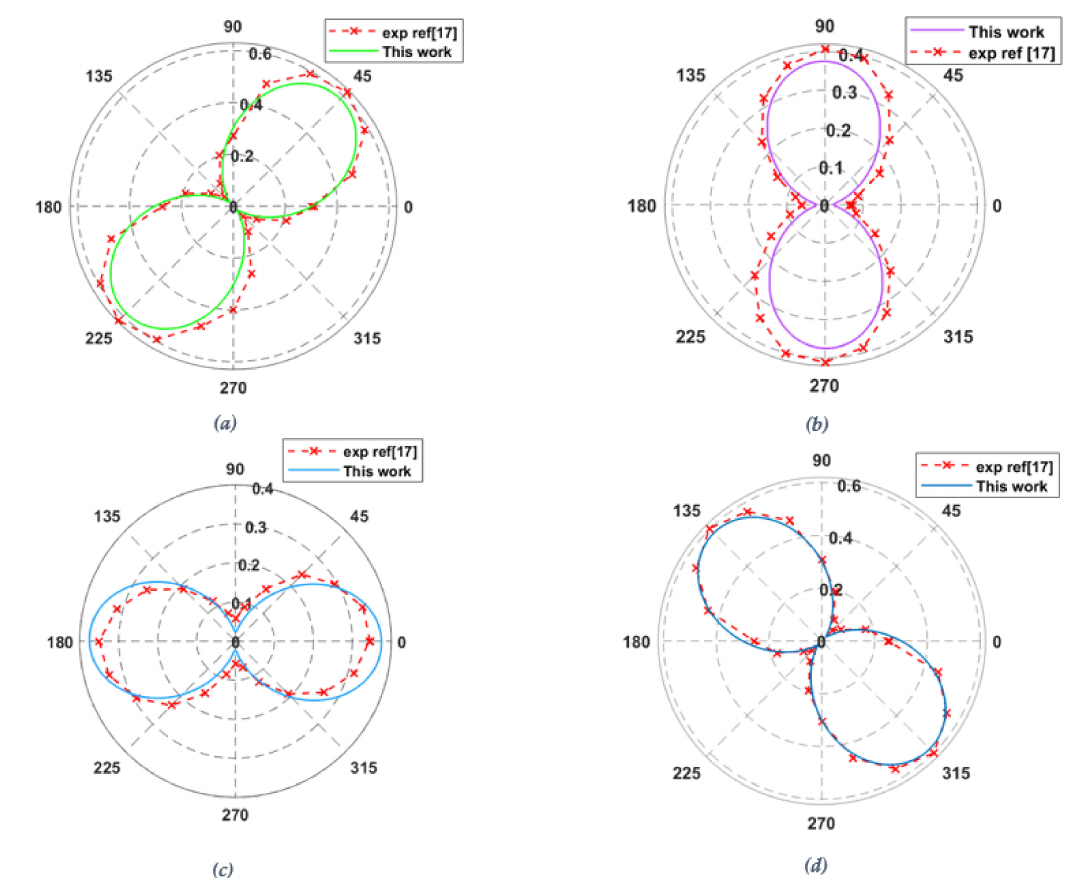
Figure 8. ( a – d ) Polar plot of the input power when the receiver is placed at 0 ◦ , 45 ◦ , 90 ◦ , and 135 ◦ , respectively, in the presence of rotating magnetic field when d = 0.3